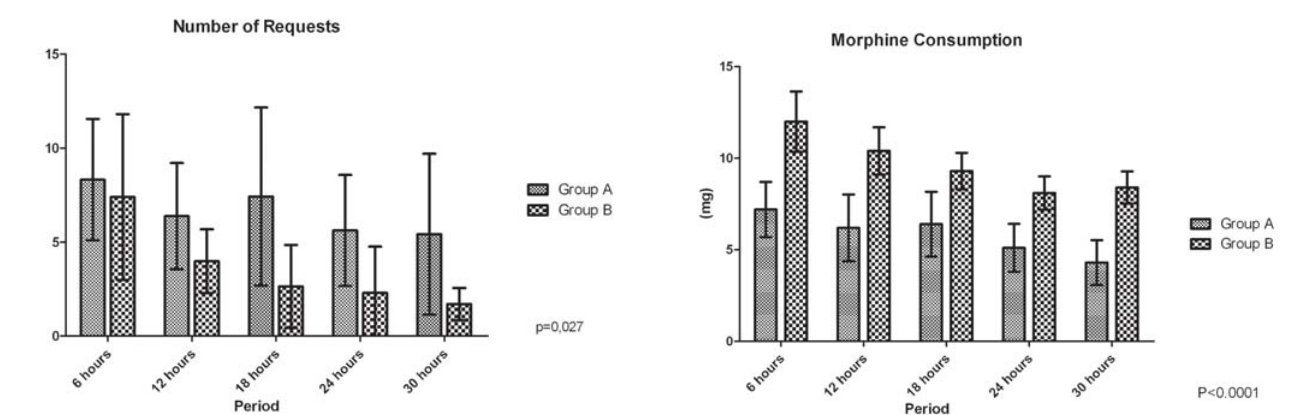
Fig. 1 - Comparison of morphine consumption between groups in all evaluated periods expressed in (mg) mean with 95% CI